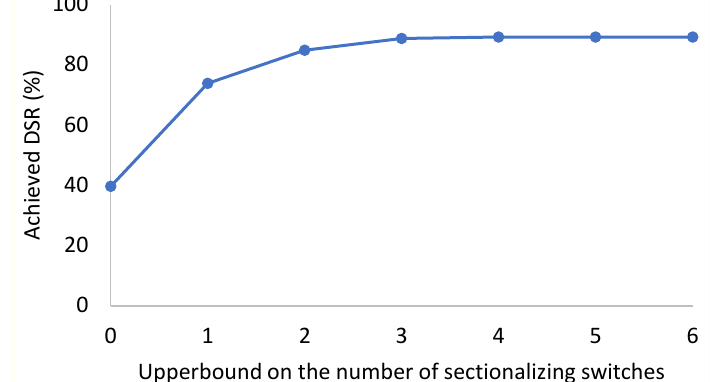
Figure 4. Average achieved DSR with limit on utilized sectionalizing